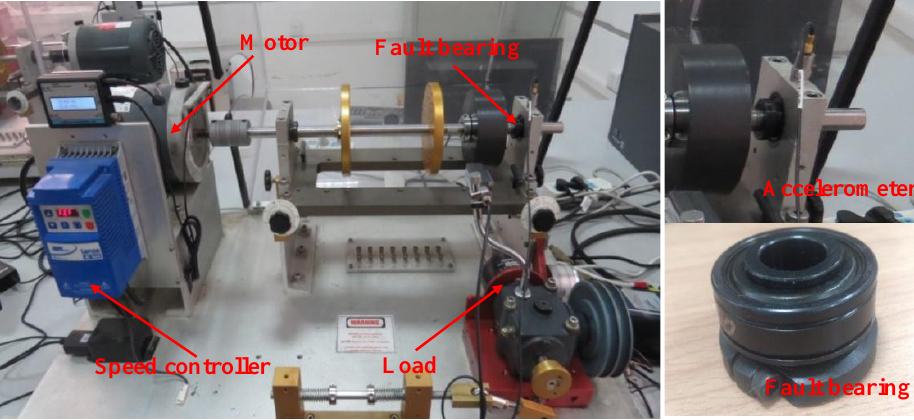
Figure 12. Setup and fault bearing.